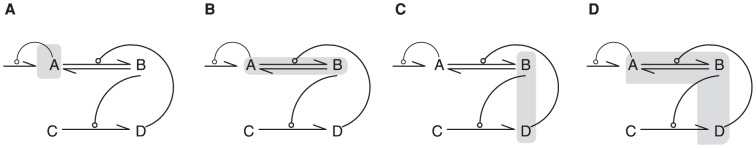
Example for the definitions of reaction networks and cycles.There are four cycles in this example network, given by  and , shown in shaded areas. Panels A to D show cycles  respectively. The arrow  refers to a reaction while the arrow  indicates the catalytic effect on a reaction.